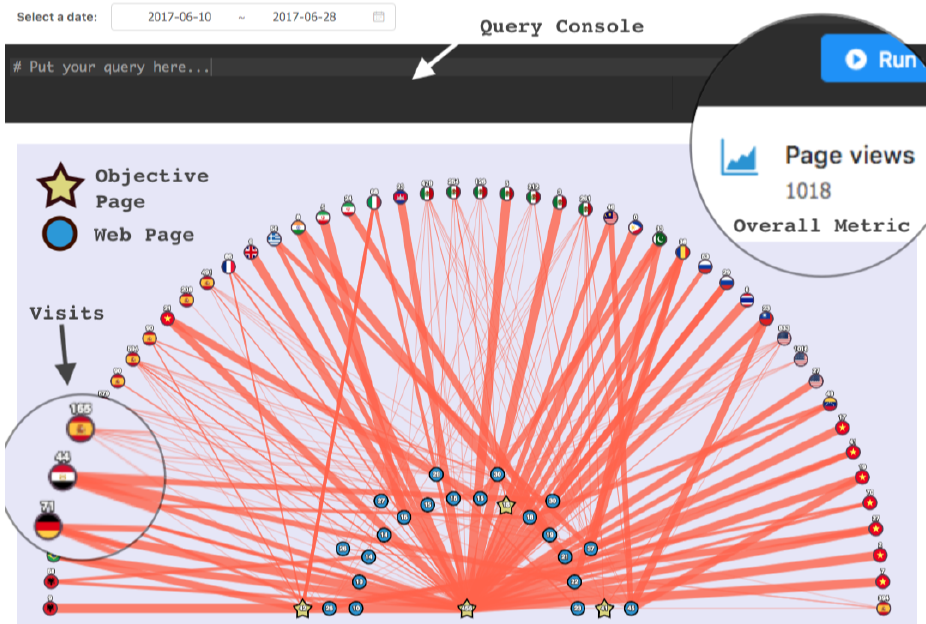
Figure 9. An example of the visualization proposed by B. Cervantes et al. [35]. Blue nodes are web pages, starts are objective pages, and nodes with country flags are visits of users from that